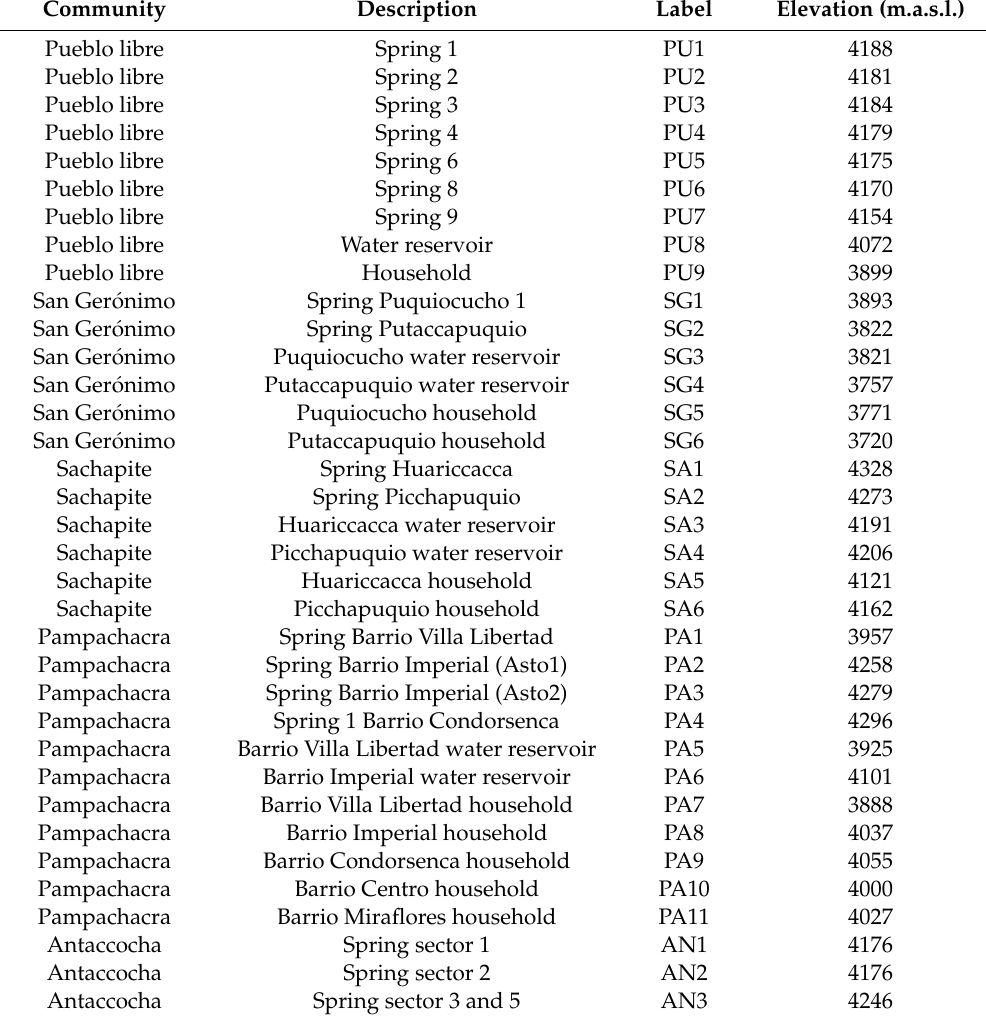
Table A1. Description of sampling points (springs, water reservoirs, and households).